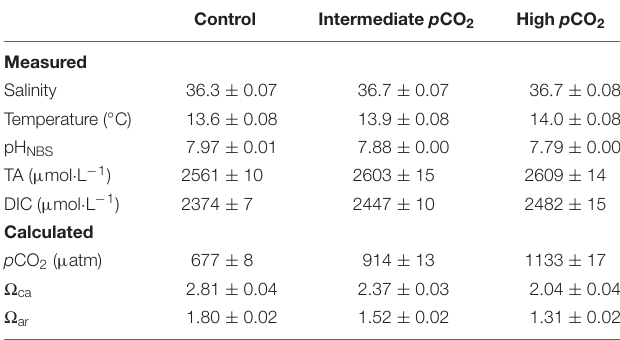
TABLE 1 | Seawater carbonate chemistry in the seawater acidification